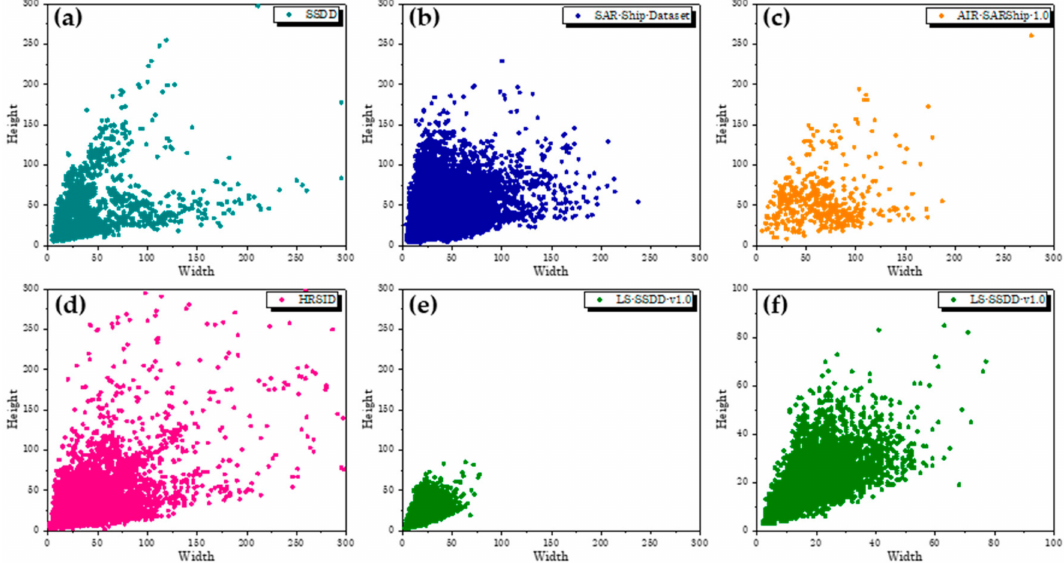
Figure 11. Ship pixel size distribution of di ff erent datasets. ( a ) SSDD; ( b ) SAR-Ship-Dataset; ( c ) AIR-SARShip-1.0; ( d ) HRSID; ( e ) LS-SSDD-v1.0; ( f ) coordinate axis enlarged display of ( e